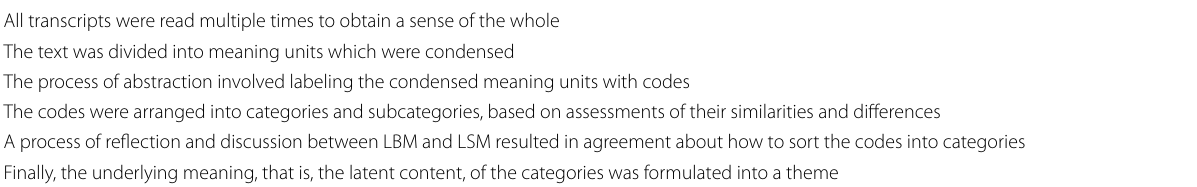
Table 1 The steps during analysis, inspired by Graneheim and Lundmann All transcripts were read multiple times to obtain a sense of the whole The text was divided into meaning units which were condensed The process of abstraction involved labeling the condensed meaning units with codes The codes were arranged into categories and subcategories, based on assessments of their similarities and differences